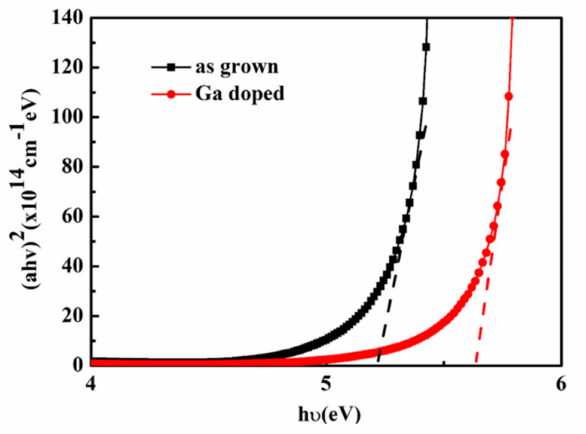
Figure 5. The curve of ( ahv ) 2 versus hv for ZnMgO samples. The band gaps are 5.54 eV and 5.20 eV for the Ga doped and undoped ZnMgO films, respectively. After Ga dope the band gap of ZnMgO increases, which indicates an increase in Mg content. The result is consistent with the conclusion of XRD and XPS. The current-voltage characteristics of the ZnMgO sample with and without Ga dope are measured under dark and UV illumination conditions, respectively. In Figure 6a, under UV illumination, at 5 V bias, the current for undoped and doped ZnMgO UVPD was 0.82 mA and 5.2 mA, respectively. While under dark conditions, the dark current for undoped and doped ZnMgO was 0.62 mA and 3.4 mA, respectively. The results I–V indicate that Ga dope can effectively enhance the current of